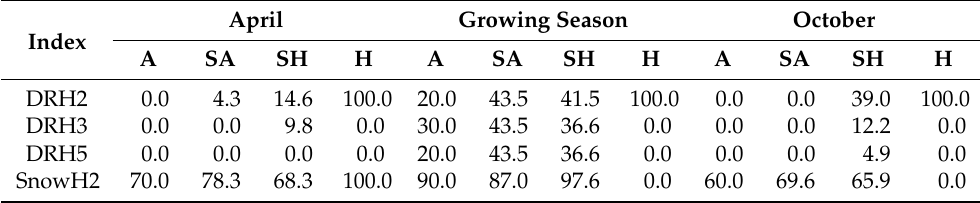
Table 4. Percentages (%) of stations with significant annual variability in the precipitation metric indices with ecological relevance across the climatic zones. The character “A” denotes arid areas; “SA” denotes semiarid areas; “SH” denotes semihumid areas; “H” denotes humid areas; and “/” means no analysis of this index was conducted during the given